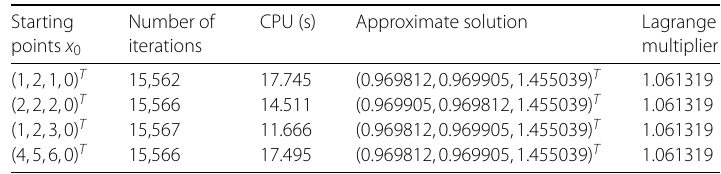
Table 7 Results for Example 5.6 using Algorithm in Corollary